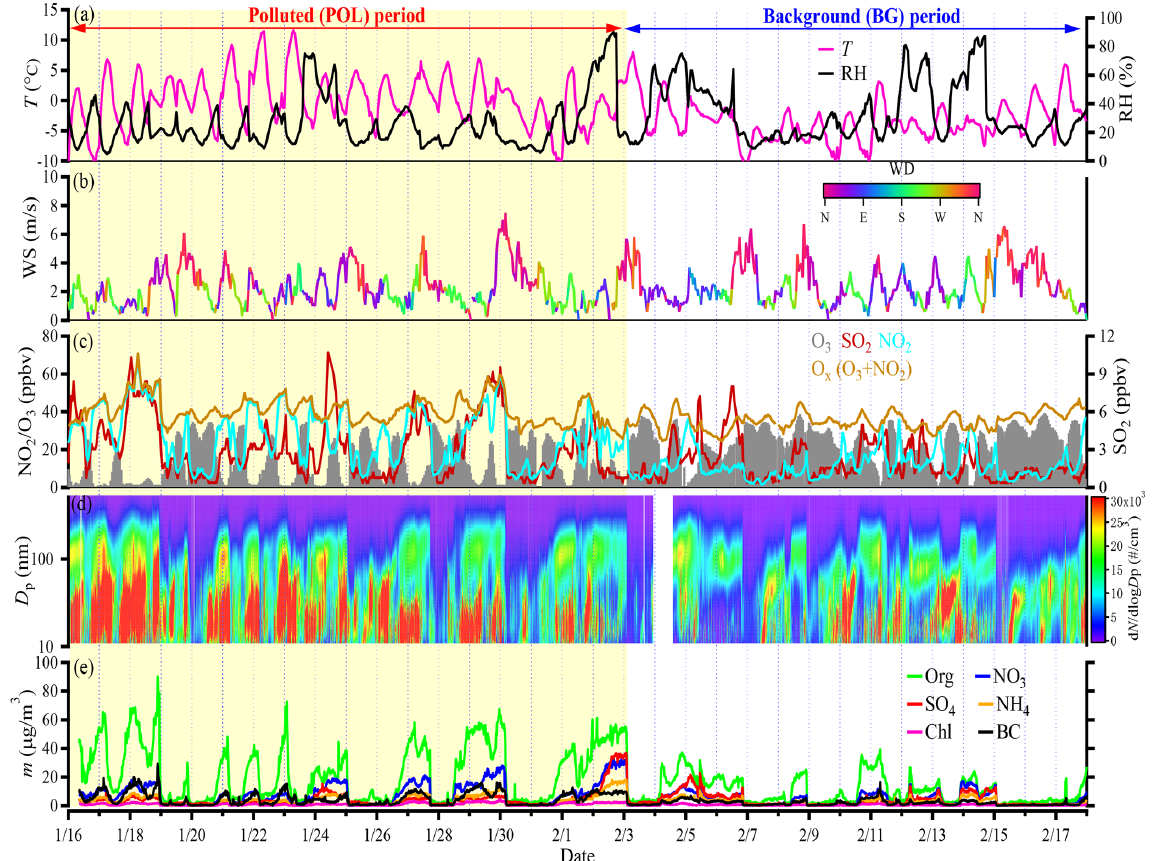
Figure 2. Time series of (a) ambient temperature ( T ) and relative humidity (RH), (b) wind direction (WD) and speed (WS), (c) volume mixing ratios of trace gases [O 3 , SO 2 , NO 2 , and O x (O 3 + NO 2 )], (d) the aerosol particle number size distribution measured by the SMPS, and (e) mass concentrations of aerosol chemical species in PM 2 . 5 measured by the ACSM and the AE-33. The trace gas information was from the Yizhuang station, and the others were observed at the experiment site in Beijing (16 January to 17 February